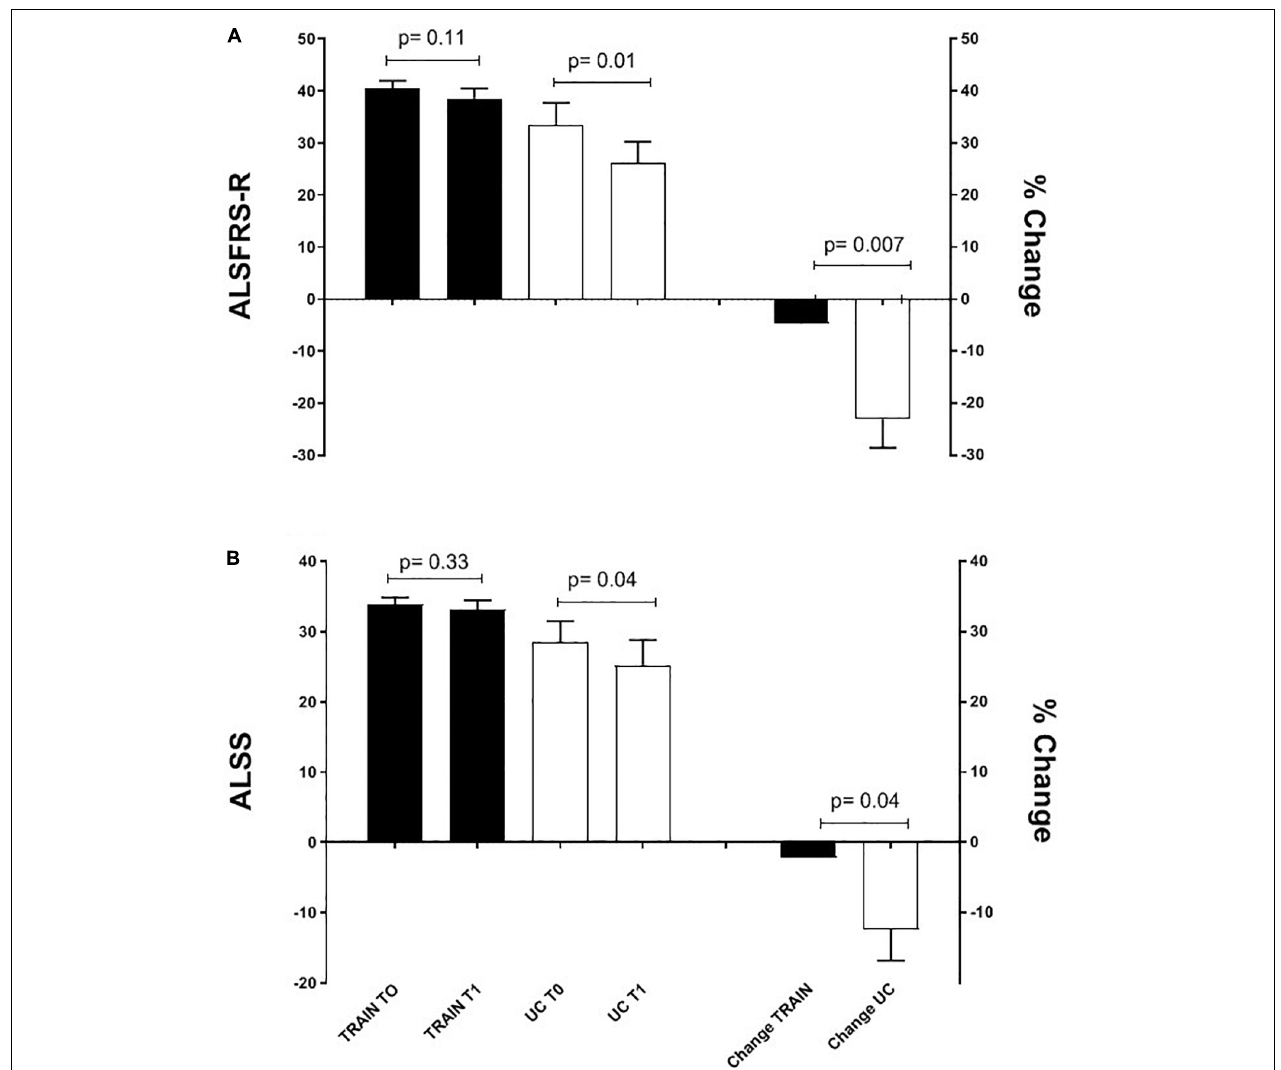
FIGURE 5 | Mean ALSFRS-R (A) and ALS-SS (B) scores before (T0) and after 12 weeks (T1) of exercise training (TRAIN) and usual care (UC), and mean changes expressed as a percentage. Average data are expressed as mean +